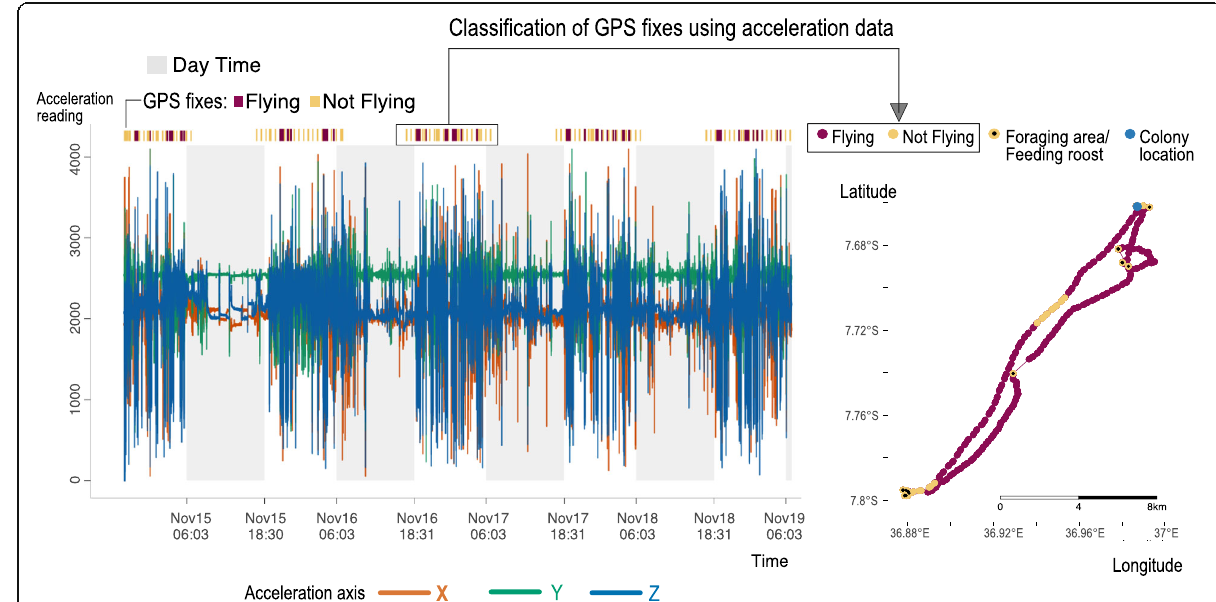
Fig. 1 Left: Classification of GPS fixes based on temporally associated acceleration bursts along Y- (backward-forward) and Z- (up-down) axes. Right: The GPS fixes corresponding to a bat ’ s third foraging night, classified as ‘ Flying ’ and ‘ Not Flying ’ , and further subsetted into foraging areas/ feeding roost